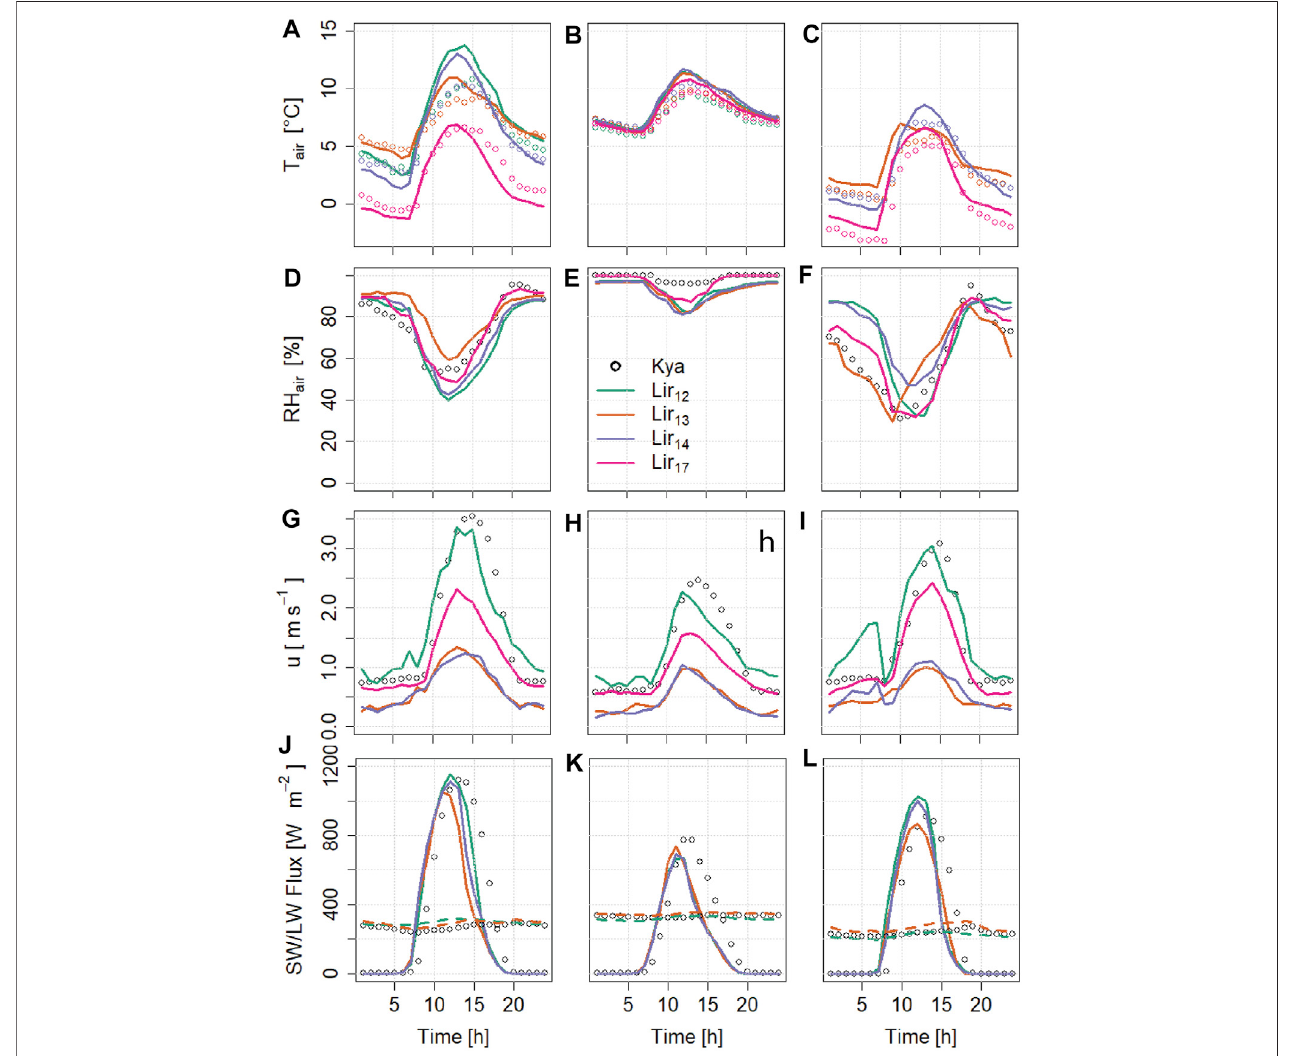
FIGURE6| Meandiurnalcyclesforclimatevariablesusedintheenergybalance,includingairtemperature (A – C) ,relativehumidityoftheair (D – F) ,windspeed (G – I) and incoming shortwave (solid lines) and longwave radiation (dashed lines, (J – L) ). For air temperature the lapsed data from Kyanjing (Kya) to the respective on-glacier location is shown. Wind speed at Kyanjing is shown with a factor of 0.5. The three columns represent three seasons, pre-monsoon, monsoon and post-monsoon from left to right. Lir 12-17 refers to the AWS on Lirung Glacier. Lir 17 was operational from September 2016 to October 2018, while all other setups only measured during the monsoon in the respective year (see Supplementary Table S1 for exact